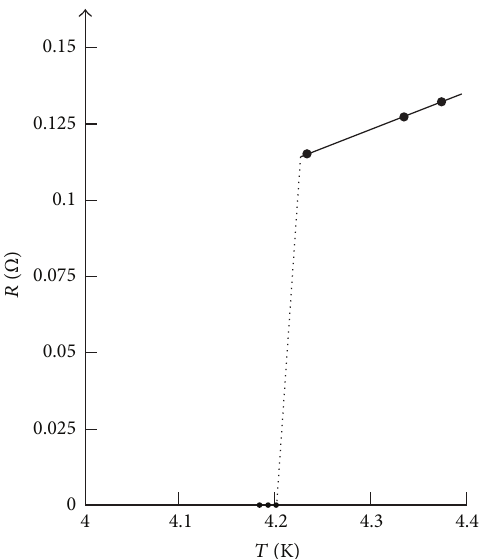
Figure 8: Initial data from Onnes’s resistance measurements on mercury showing a precipitous fall in resistance around 𝑇 𝐶 = 4.2